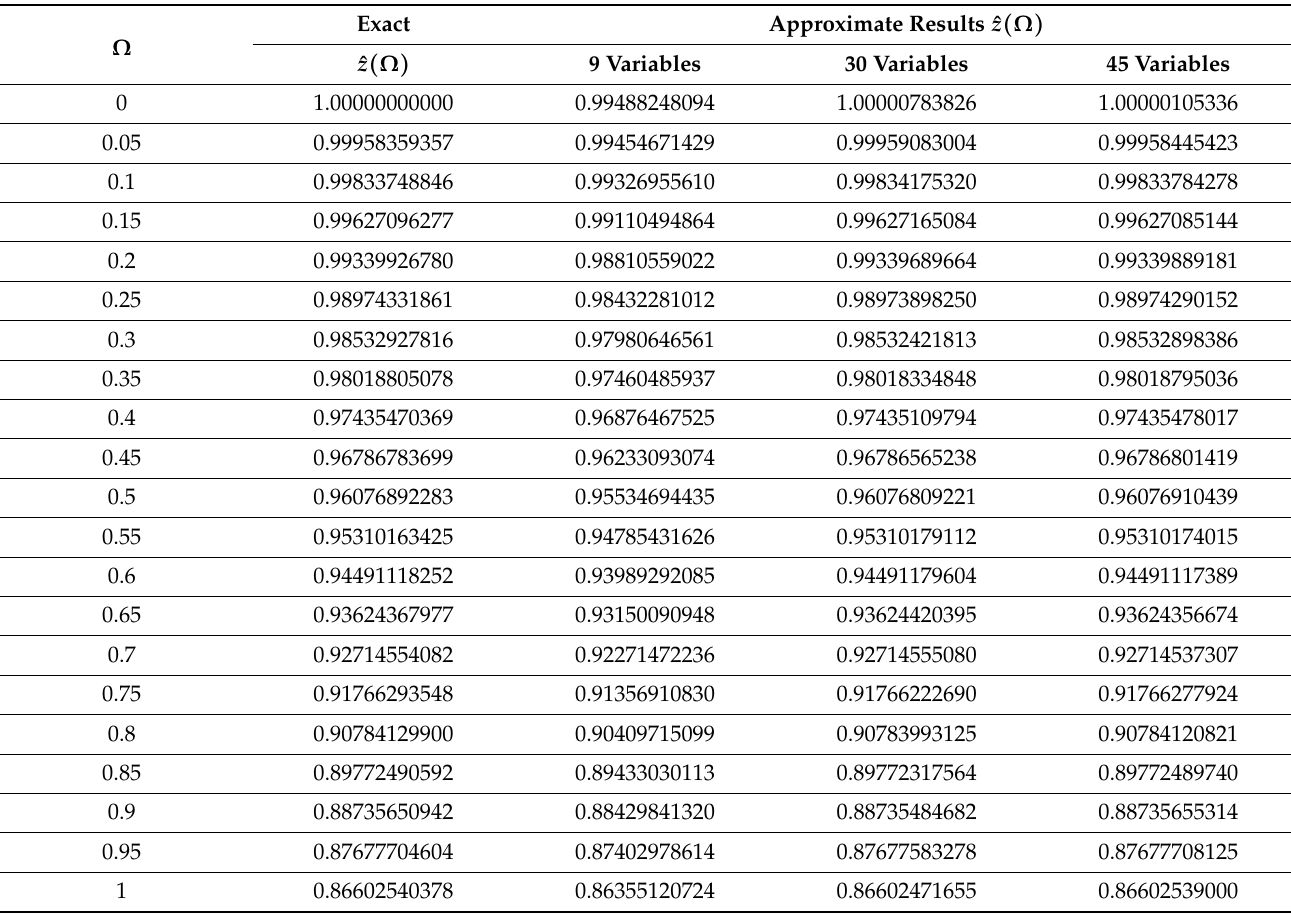
Table 5. Results comparison of Problem 4 using ANN-GA-SQPM based on three, 10 and 15 neurons or nine, 30, and 45 variables with the reference